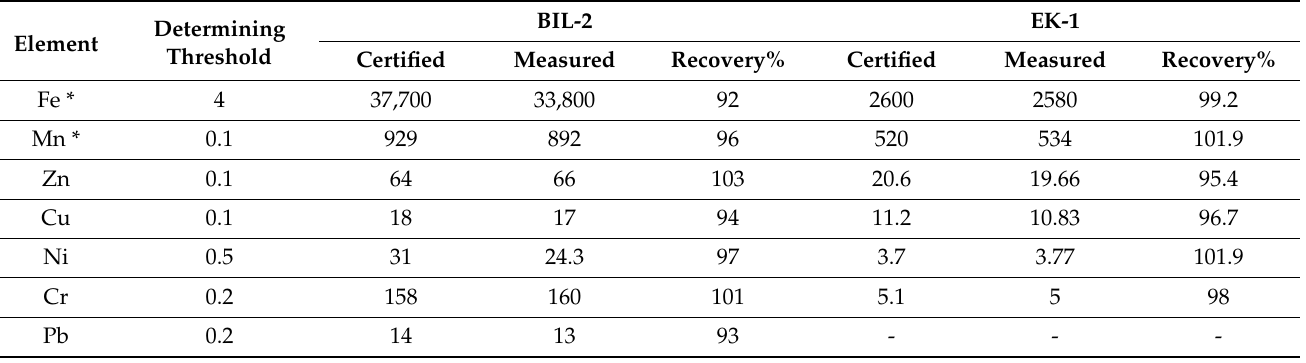
Table 1. Results of analysis of (mg/kg) of standard reference materials. (mean ± standard